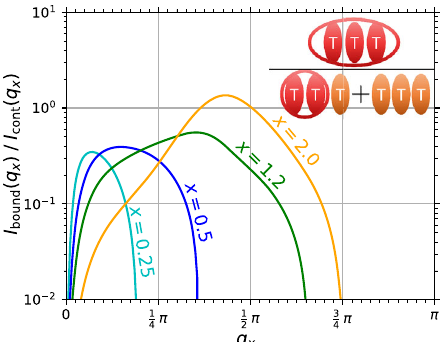
Fig. 5 Ratio of bound to continuum excitations weight. The ratio is computed using the spectral weight I bound of the three-triplon bound state and the weight I cont of the continuum of three-triplon scattering states for = π / a . The groups of ellipses with the letter ‘ T ’ denote three-triplon q y states. Asymptotically scattering triplons are colored orange and bound triplons are colored